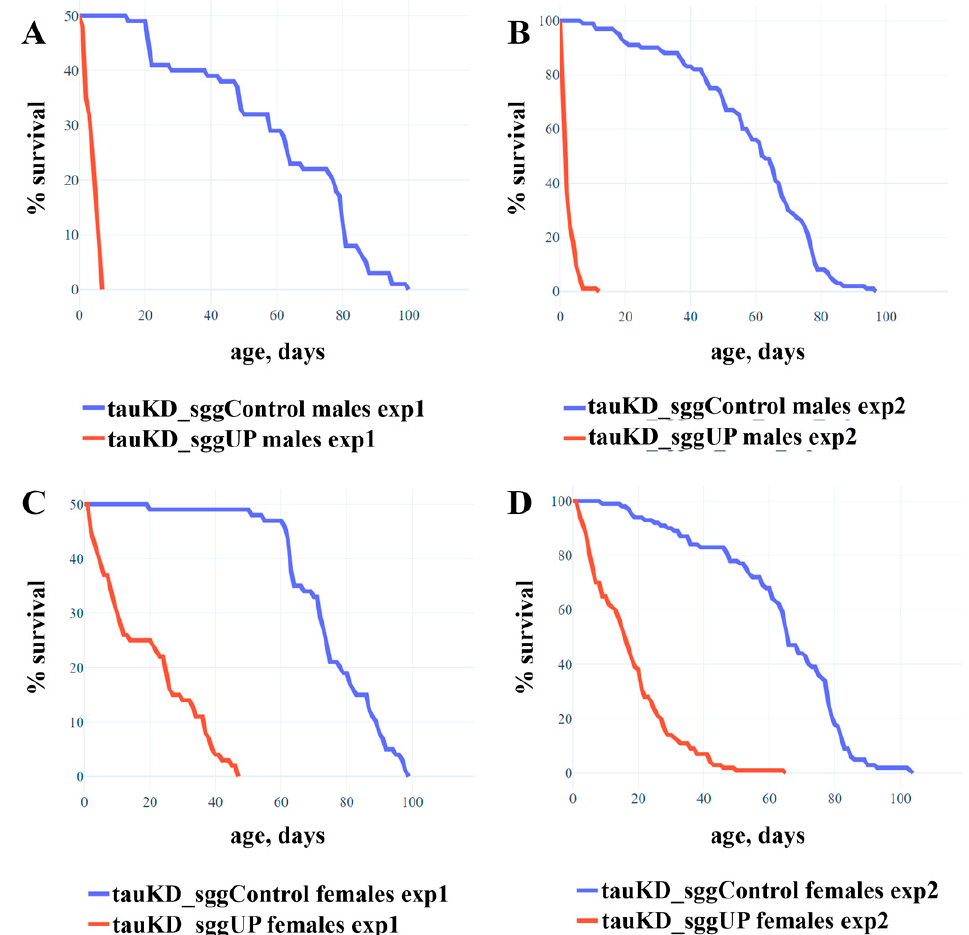
Figure 4. Co-activation of transgenes that decrease the expression of the tau gene and increase the expression of the RB transcript of the shaggy gene reduces the lifespan of males and females. ( A , B )—Experiments 1 and 2 with males. ( C , D )—Experiments 1 and 2 with females. A detailed description of the genotypes is given in the Materials and Methods section. Statistical analysis of the data is given in the Supplementary Materials Table S4.